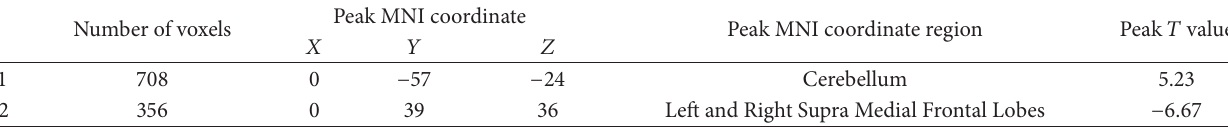
Table 4: Significant ALFF differences between two groups with their location.